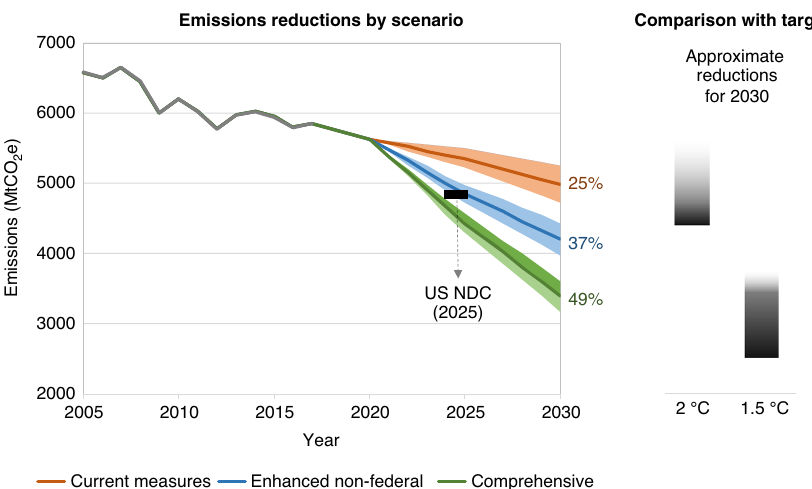
Fig. 2 Rapidly expanded bottom-up action could reduce U.S. emissions signi fi cantly. Current measures can deliver reductions of 25% below 2005 levels by 2030; enhanced non-federal action can deliver up to 37% reductions, and a comprehensive strategy that layers ambitious federal action on top of state and other sub-national action can deliver up to 49% below 2005 levels by 2030. The gray line shows historical emissions drawn from EPA data. Given large uncertainties and limitations in connecting individual country emissions to global temperature pathways, the shading in the 2 and 1.5 °C bars on the right is